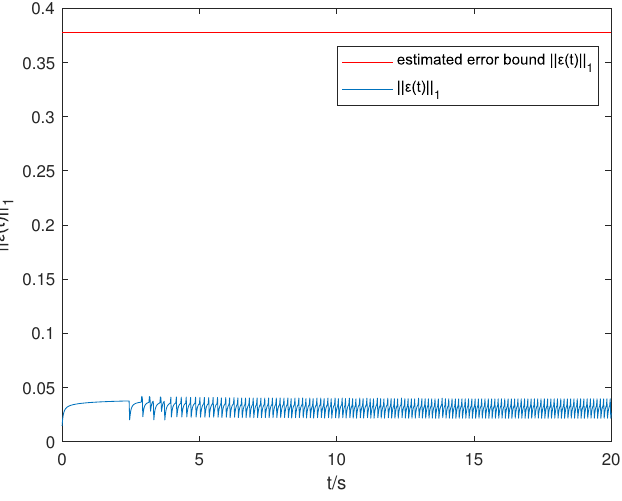
Figure 2. Error bound and (cid:107) ε ( t ) (cid:107) 1 of Example 1.